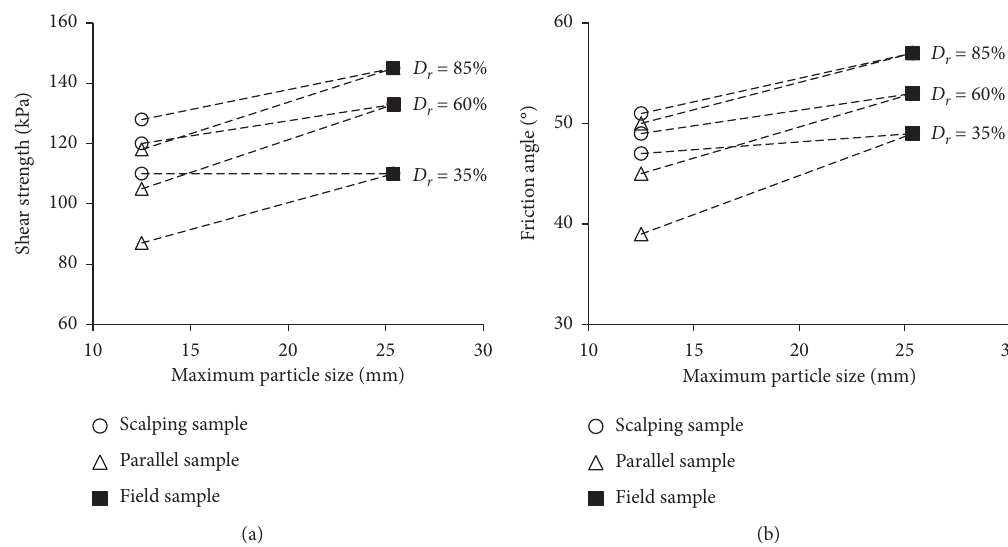
Figure 11: Variations of (a) shear strength (normal stress � 100 kPa) and (b) friction angle of field, parallel, and scalping samples as a function of maximum particle size (data taken from [67]).